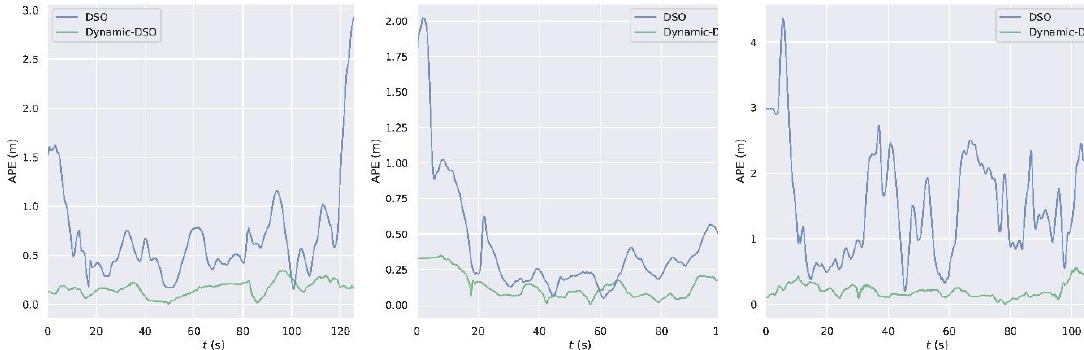
Figure 12. Comparison of the trajectory error with time between Dynamic-DSO and DSO in three synthetic sequences. Comparison in V101_syn, V201_syn and V202_syn is shown from left to right.